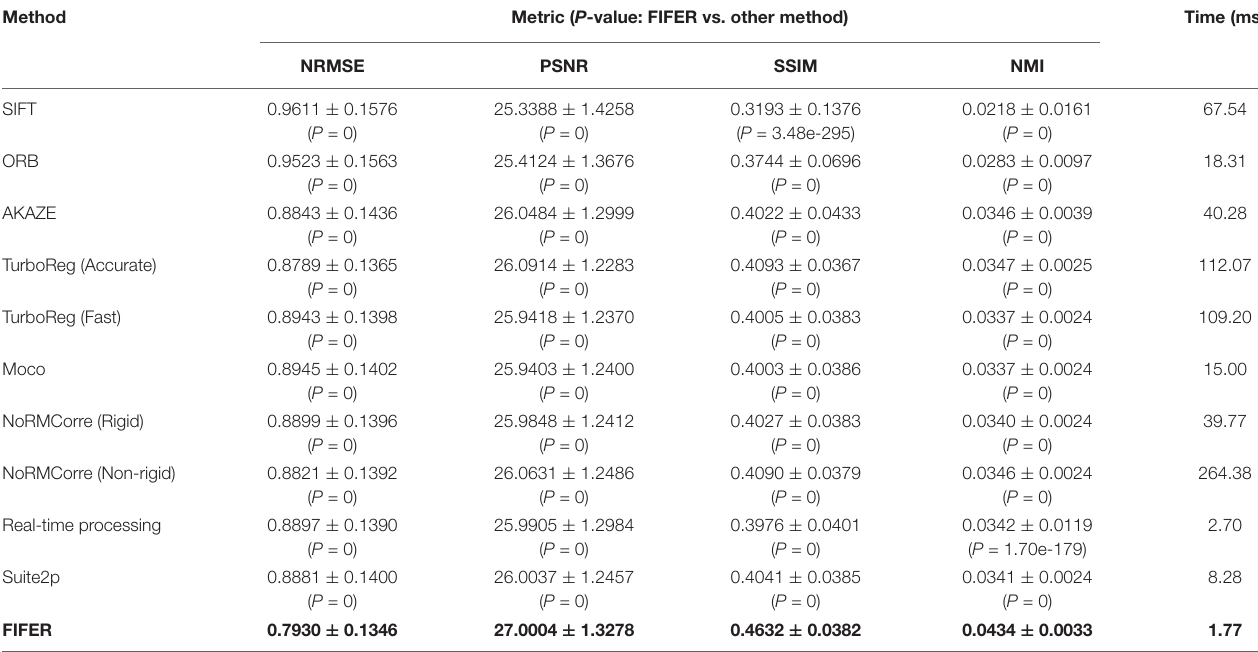
TABLE 3 | Comparison of FIFER with other methods (Mean ± SD) for neuronal population imaging dataset (the CaImAn dataset file images_N.01.01, n = 1825 frames, 512 × 512 pixels for each frame). Method Metric ( P -value: FIFER vs. other